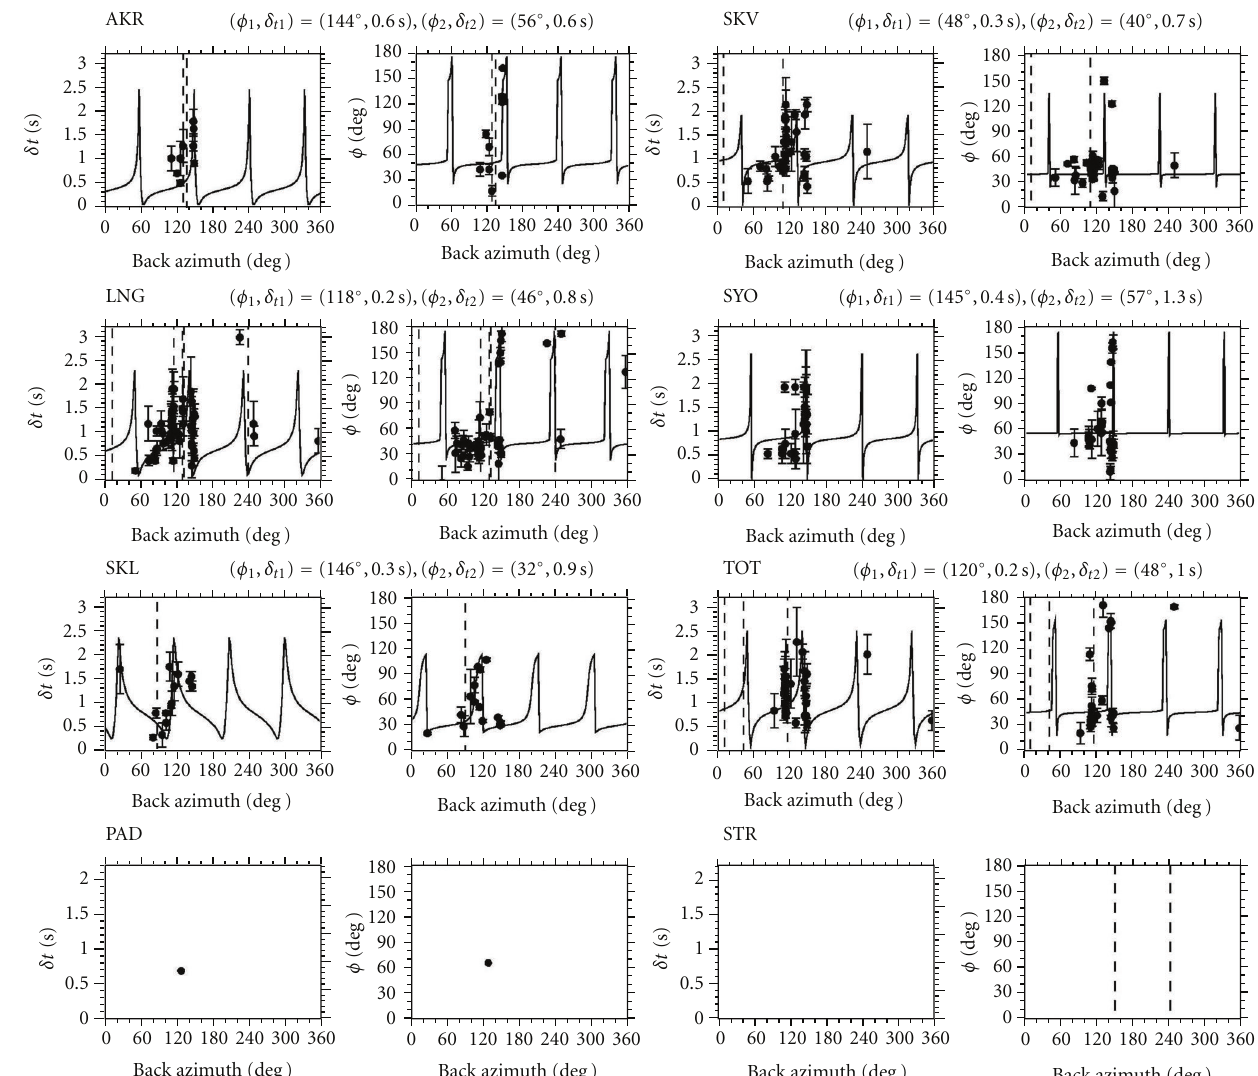
Figure 9: Splitting parameters of φ and δt plotted as a function of back azimuth. Vertical dashed lines are the direction of null measurements. At stations for AKR, LNG, SKL, SKV, SYO, and TOT, the azimuthal variations of apparent splitting parameters are modeled by a two-layer case of anisotropy. The parameter pair ( φ 1 , δt 1 ) describes the lower layer anisotropy and ( φ 2 , δt 2 ) corresponds to the upper layer. All the figures are after Usui et al.